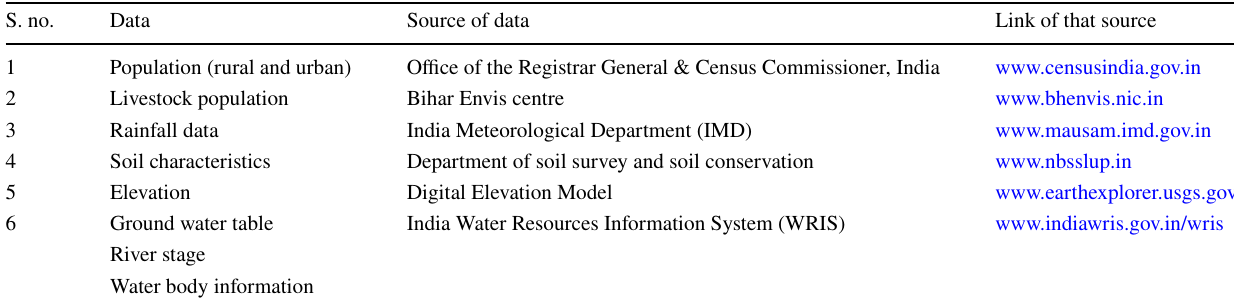
Table 4 Data used in the study and the source of that data S.